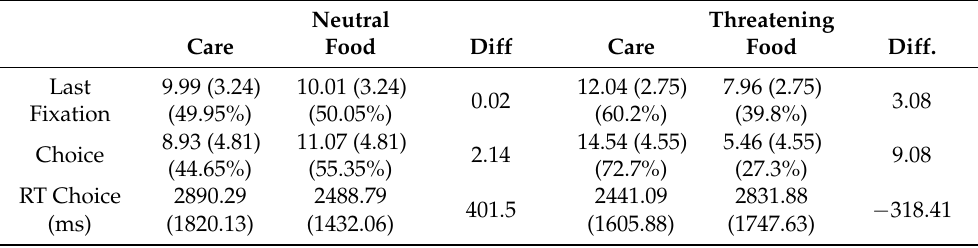
Table 2. Means, SD, and percentages of the last fixation; picture choices and